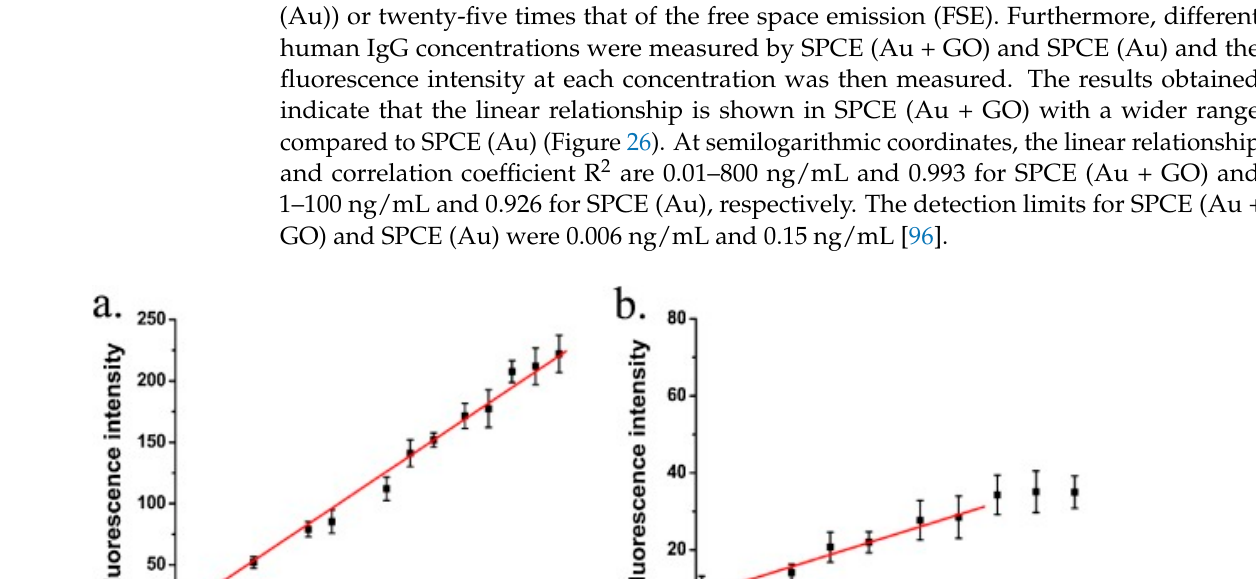
Figure 25. ( a ) AgNCs and GO enhanced SPCE structure. ( b ) The resulting fluorescence spectrum (right) (adapted with permission from Reference [95], copyright Elsevier).